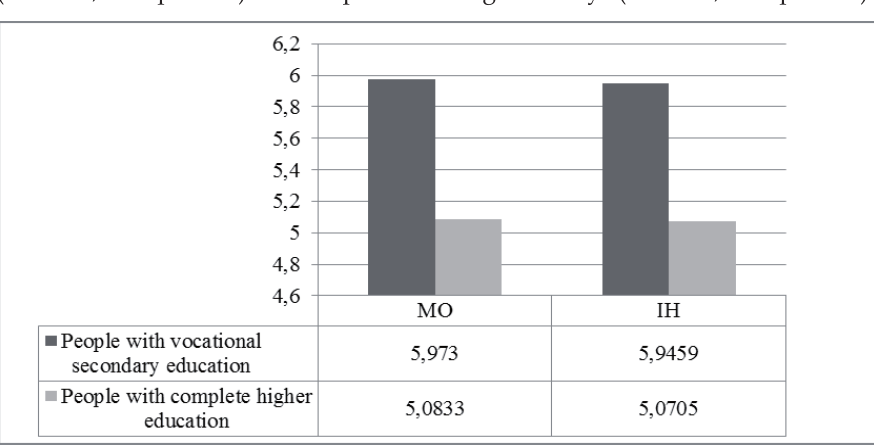
Figure 3. Statistically signi  cant differences in indicators of money attitudes in people with different level of education (p <